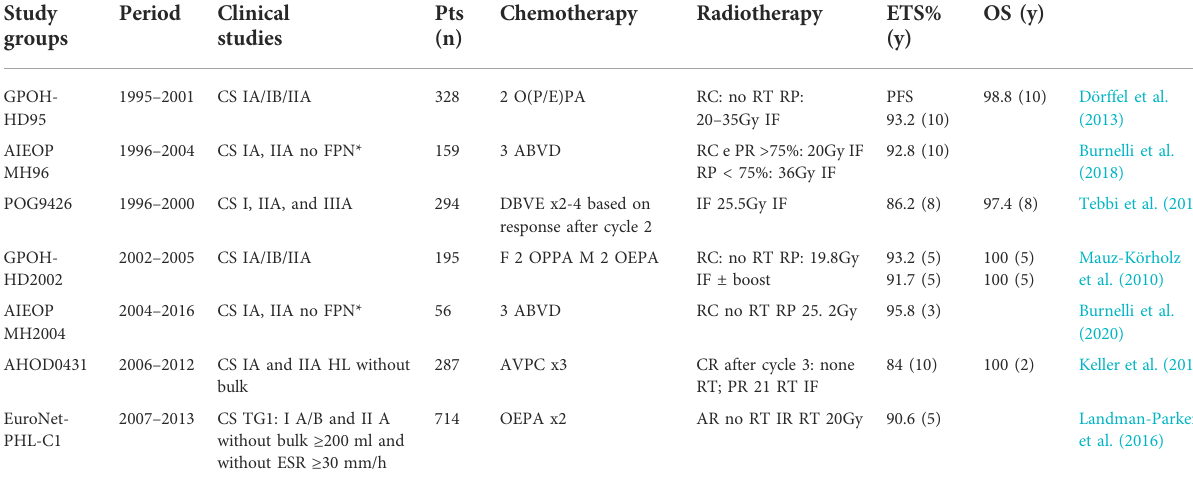
TABLE 2 Main clinical trials in pediatric patients with low-risk